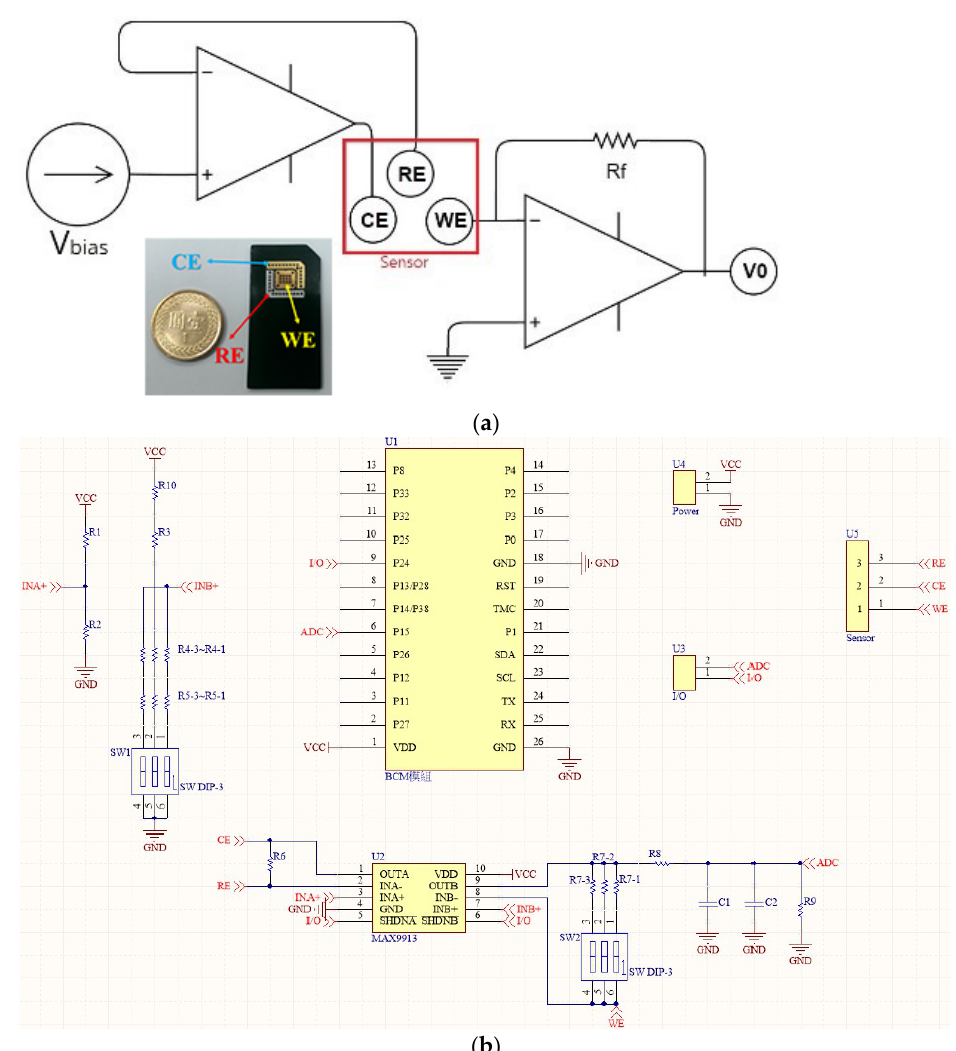
Figure 6. ( a ) Schematic diagram of the sensing circuit; ( b ) design of the sensing circuit.